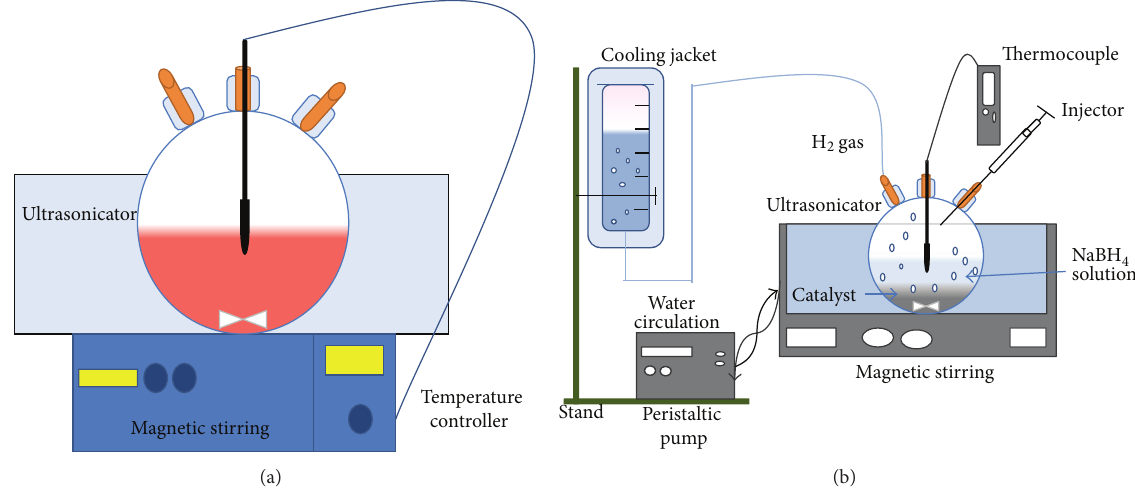
Figure 1: Experimental systems. (a) Coprecipitation and sono-coprecipitation synthesis system of Co-B catalyst. (b) Alkaline NaBH 4 sonohydrolysis/hydrolysis